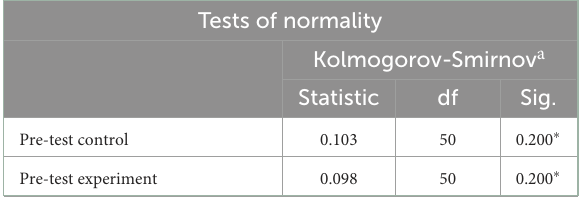
TABLE 1 Normality test